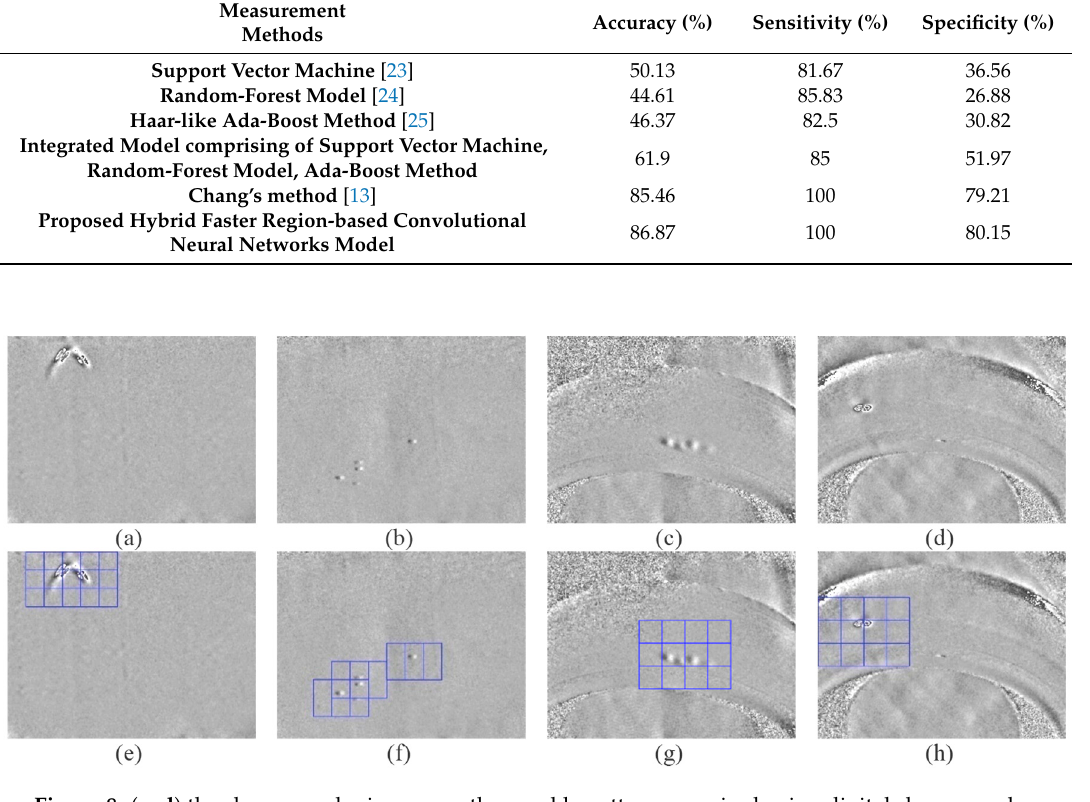
Figure 8. ( a )–( d ) the shearography images or the speckle patterns acquired using digital shearography, ( e )–( h ) the detection of bubble defects in tires using the proposed hybrid Faster Region-based convolutional neural networks model.